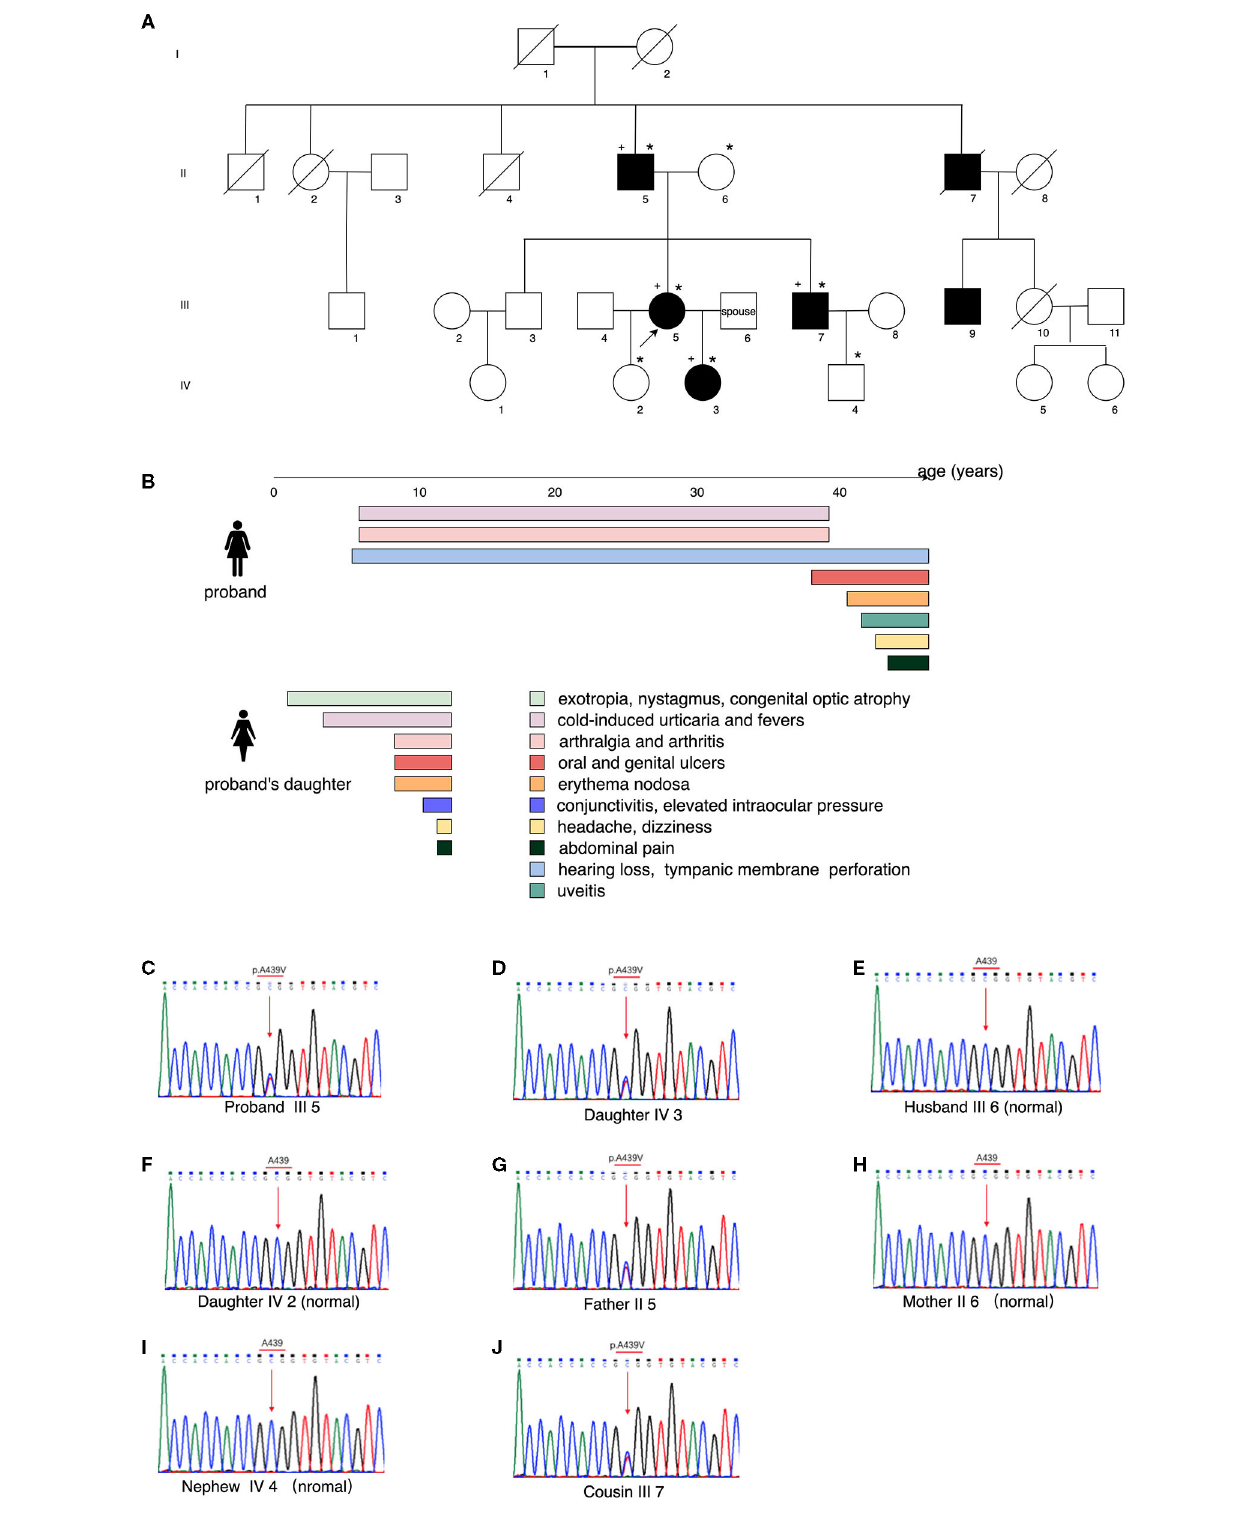
FIGURE 2 | Pedigree analysis, clinical manifestations of the proband and her daughter, and the results of whole-exome sequencing. (A) Genealogical tree of the family, showing the affected individuals (filled symbols), healthy subjects (empty symbols), the proband (III 5, black arrow), DNA samples collected (*marked, to